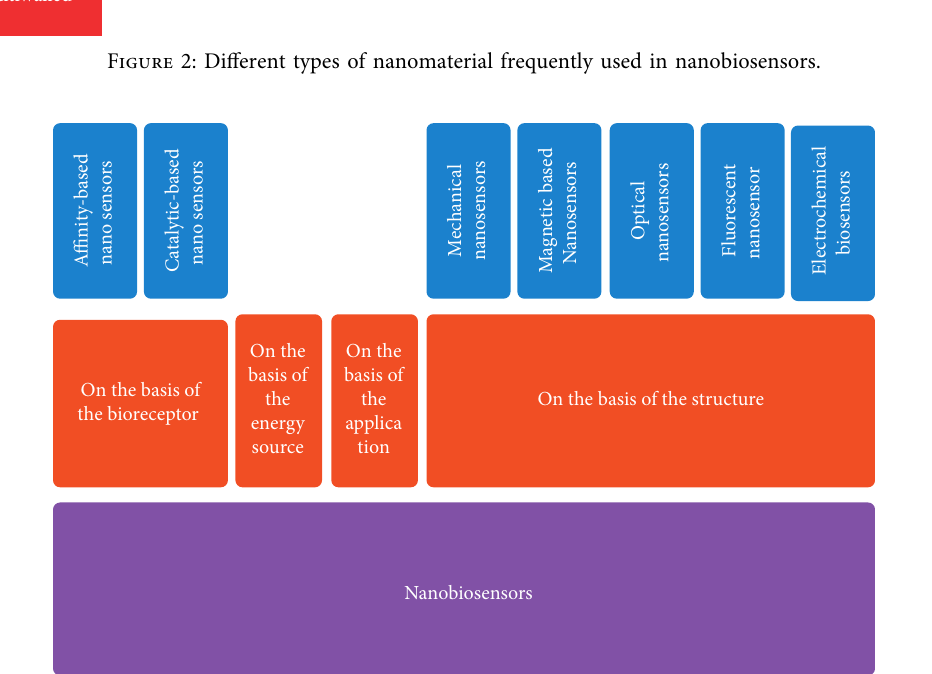
Figure 3: Classification of nanosensors.